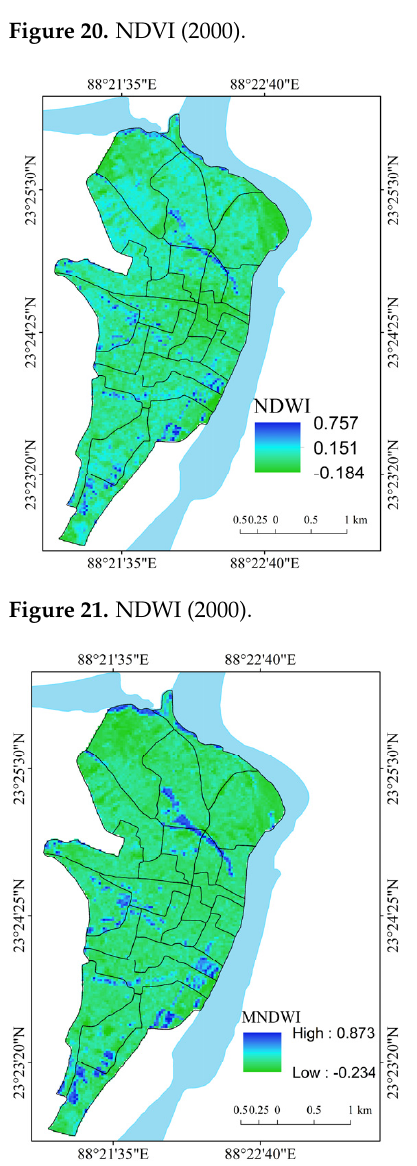
Figure 23. ND B I (2000). Figure 24. NDSI (2000).